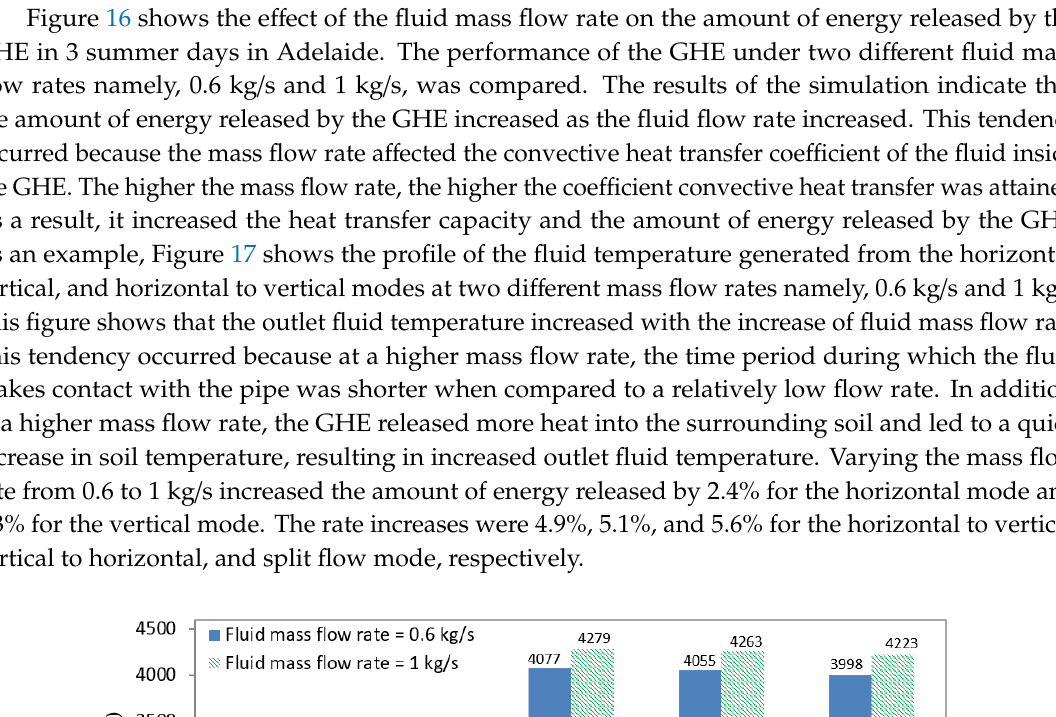
Figure 16. Energy released in 3 days by the GHE with different mass flow rate in Adelaide (where the inlet fluid temperature = 50 °C, length of horizontal GHE = 200 m, and length of vertical GHE = 200 m).